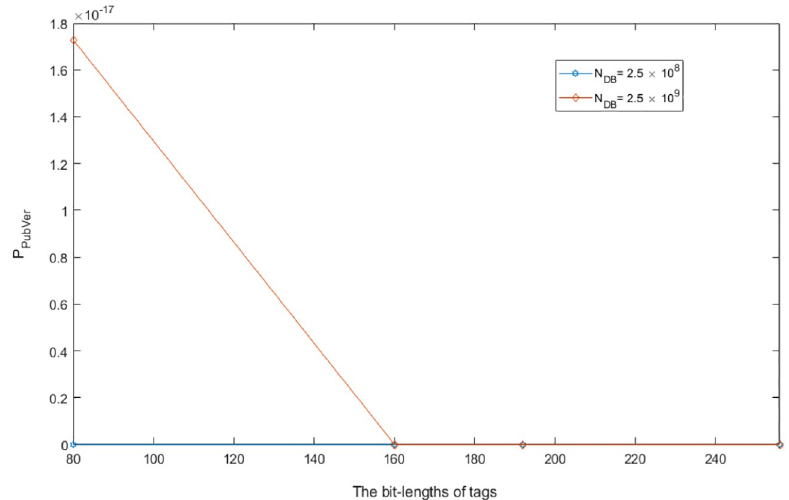
Fig 8. P PubVer vs. the bit-lengths of DBTag , En_IDTag and DBTagTag